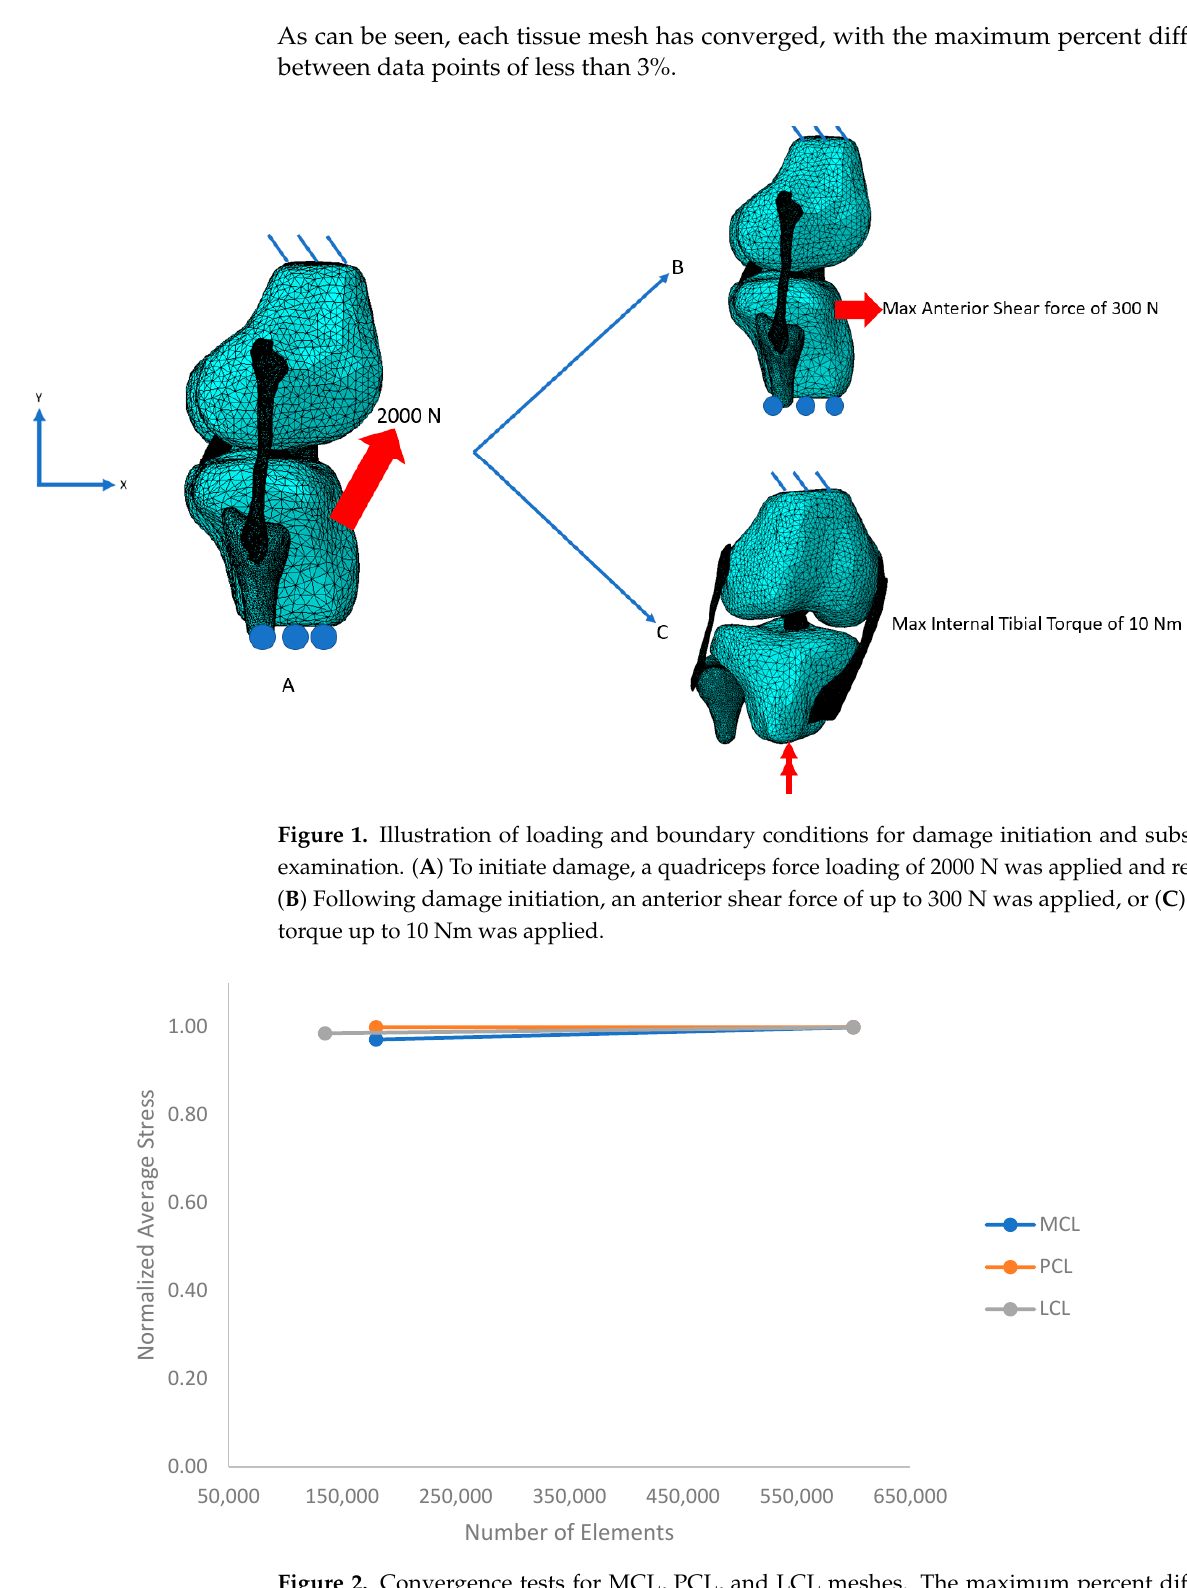
Figure 2. Convergence tests for MCL, PCL, and LCL meshes. The maximum percent difference between data points is less than 3% with an element increase of 500,000. Therefore, the meshes are converged.